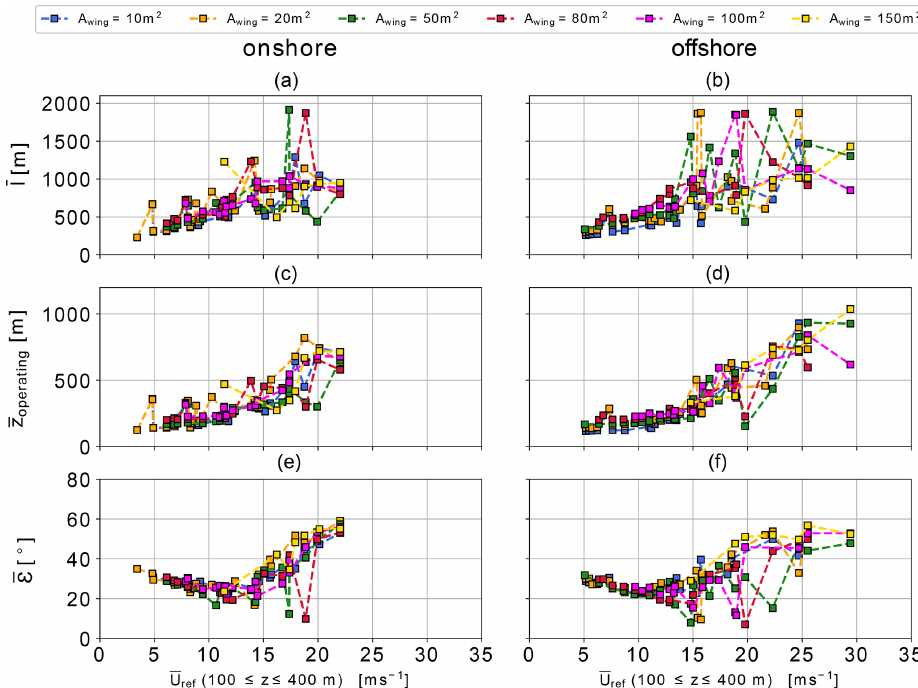
Figure 8. Average tether length l tether (a, b) , average operating altitude z operating (c, d) and average elevation angle ε (e, f) over reference wind speed U ref (100 ≤ z ≤ 400m). Results for wing areas between A = 10–150m 2 scaled with an exponent of κ = 3, AP2 reference aerodynamic coefficients for both onshore (a, c, e) and offshore (b, d, e)